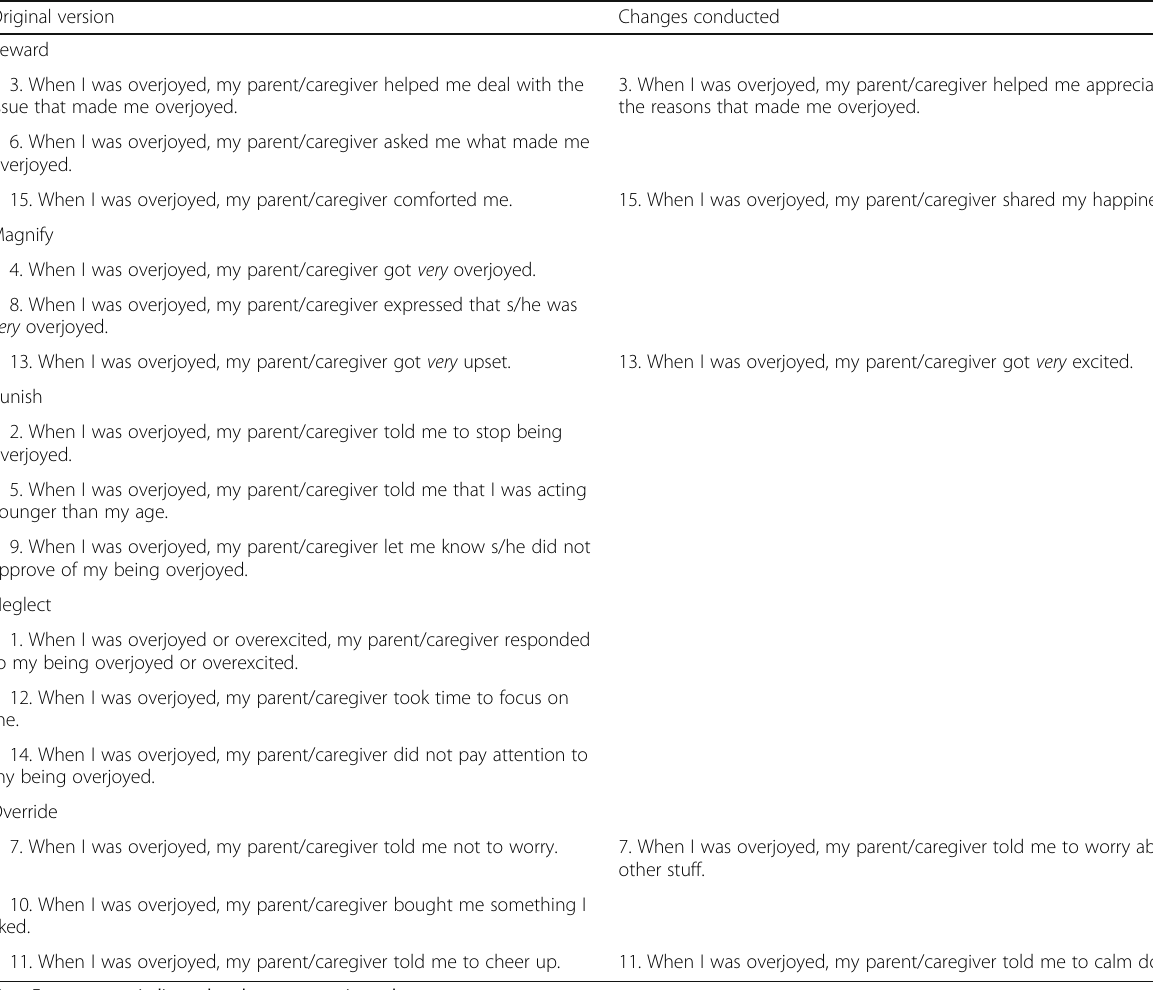
Table 1 Emotion socialization strategies for overjoy: item scale composition and changes conducted for the present study Original